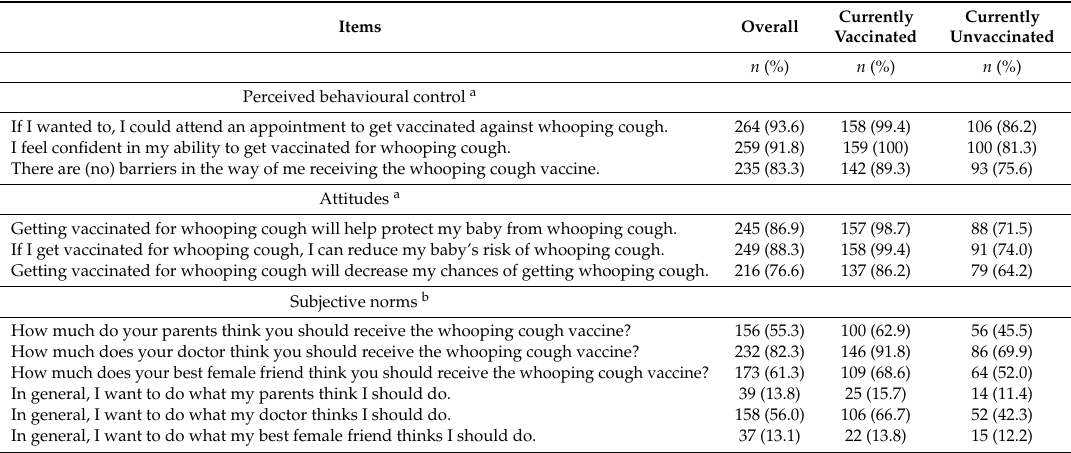
Table 2. Summary descriptives for each Theory of Planned Behaviour (TPB)